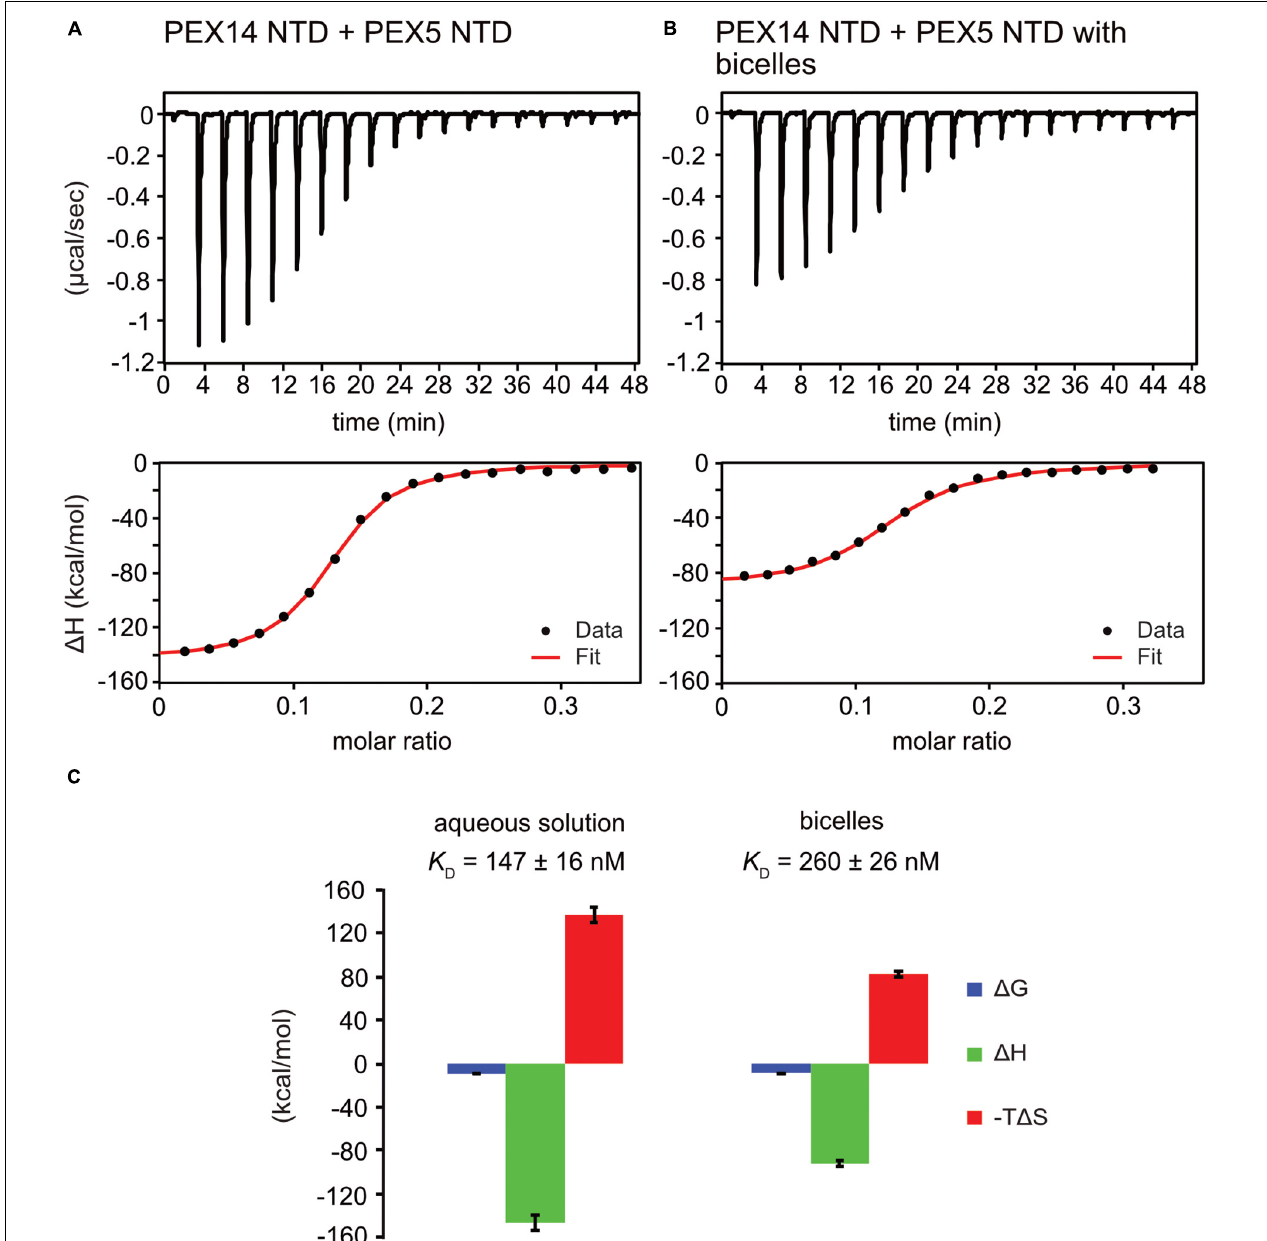
FIGURE 5 | PEX5 - PEX14 interaction by isothermal titration calorimetry. ITC experiments were performed as triplicates. (A) Titration of 50 µ M PEX5 in aqueous buffer into a 30 µ M aqueous solution of PEX14. (B) The same experiment in the presence of 44 µ M bicelle corresponding to full saturation of PEX5 and PEX14 with 0.9- fold and 1.5- fold molar excess, respectively. (C) The titration experiments in membrane-like environment show reduced binding enthalpies (cid:49) H and entropic contribution –T (cid:49) S and slightly reduced affinity compared to experiments in aqueous